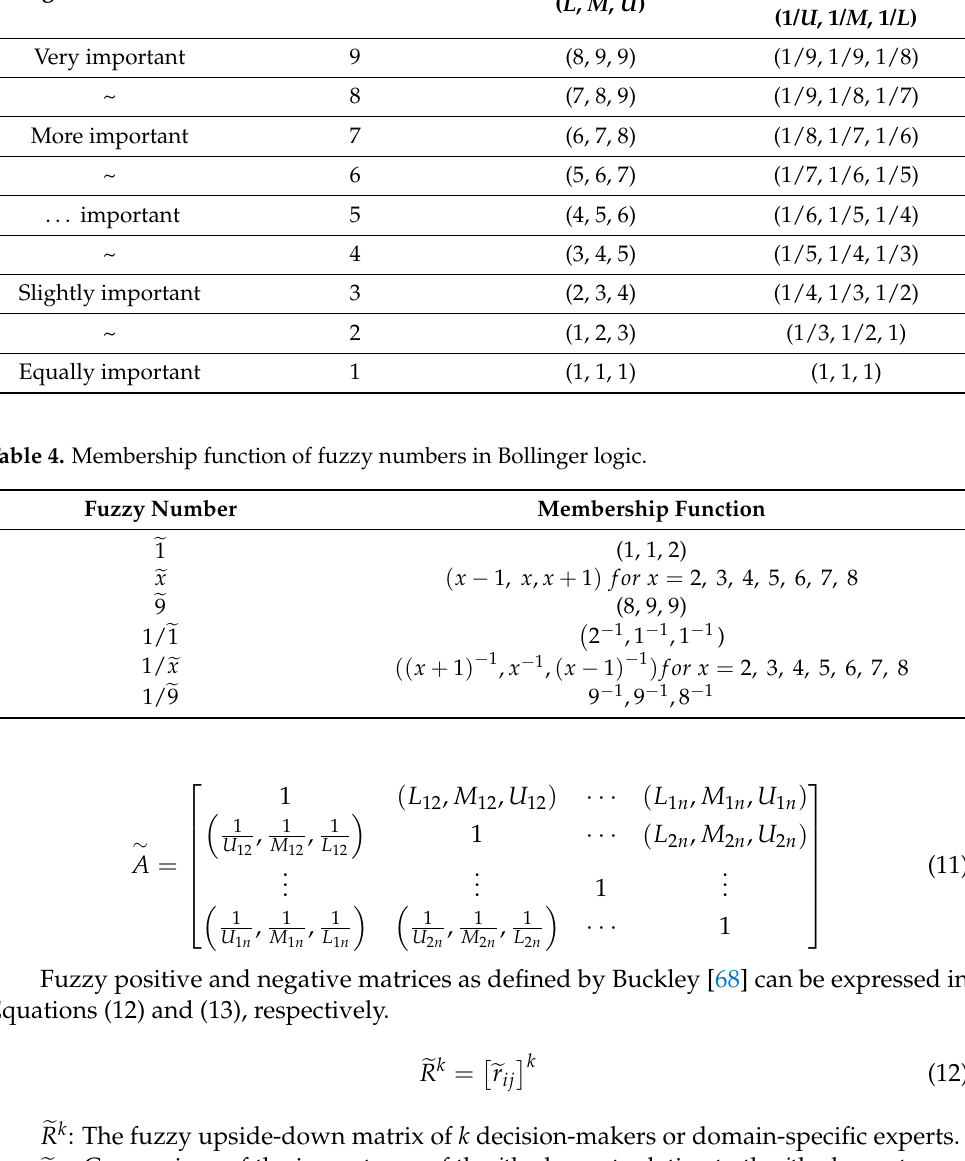
Table 3. Evaluation scale for the relative importance of OLED NPD variables. Linguistic Variables Traditional ANP